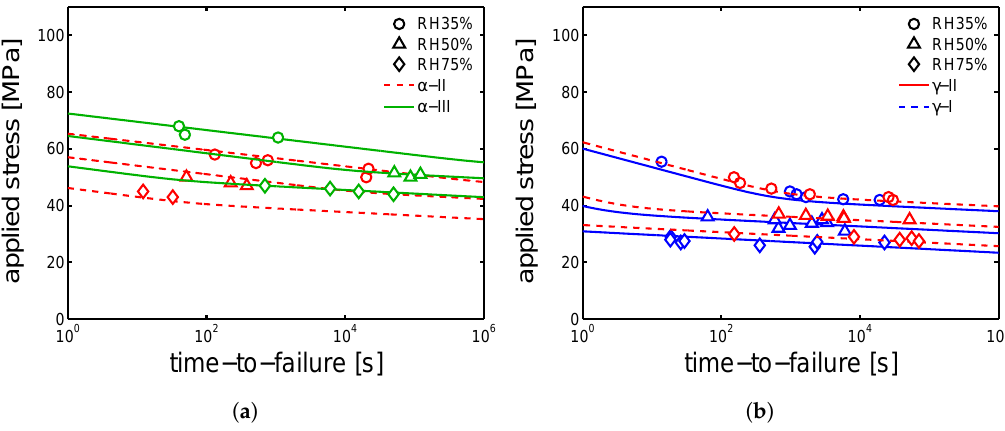
Figure 20. Creep tests for samples conditioned at RH 35%, RH 50% and RH75 % and 23 °C; applied loads as functions of time-to-failure for ( a ) α -II, α -III, ( b ) γ -I and γ -II samples. Lines are the results of Equation